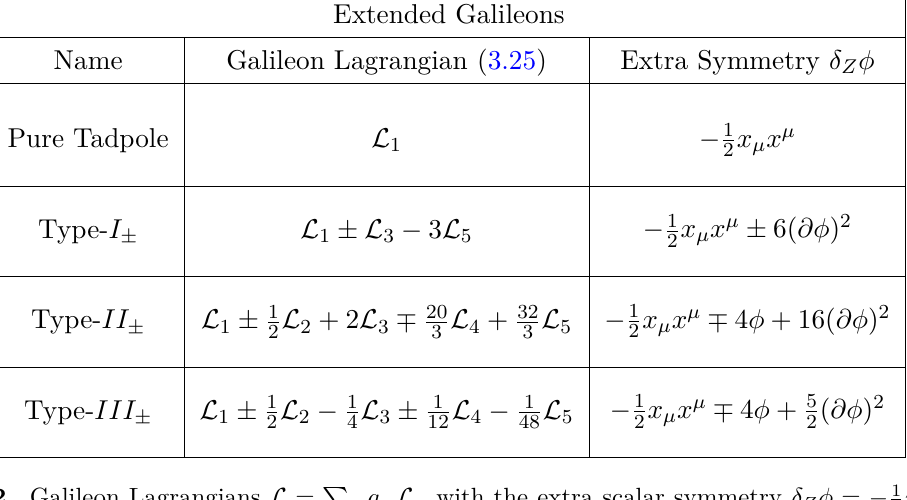
g n L n with the extra scalar symmetry δ Z φ = − 1 n